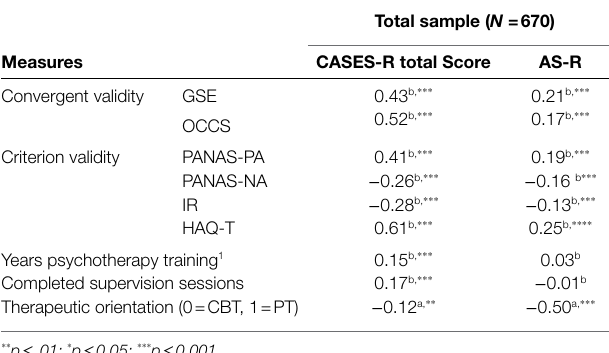
a Point-biserial correlation coefficient. b Pearson correlation